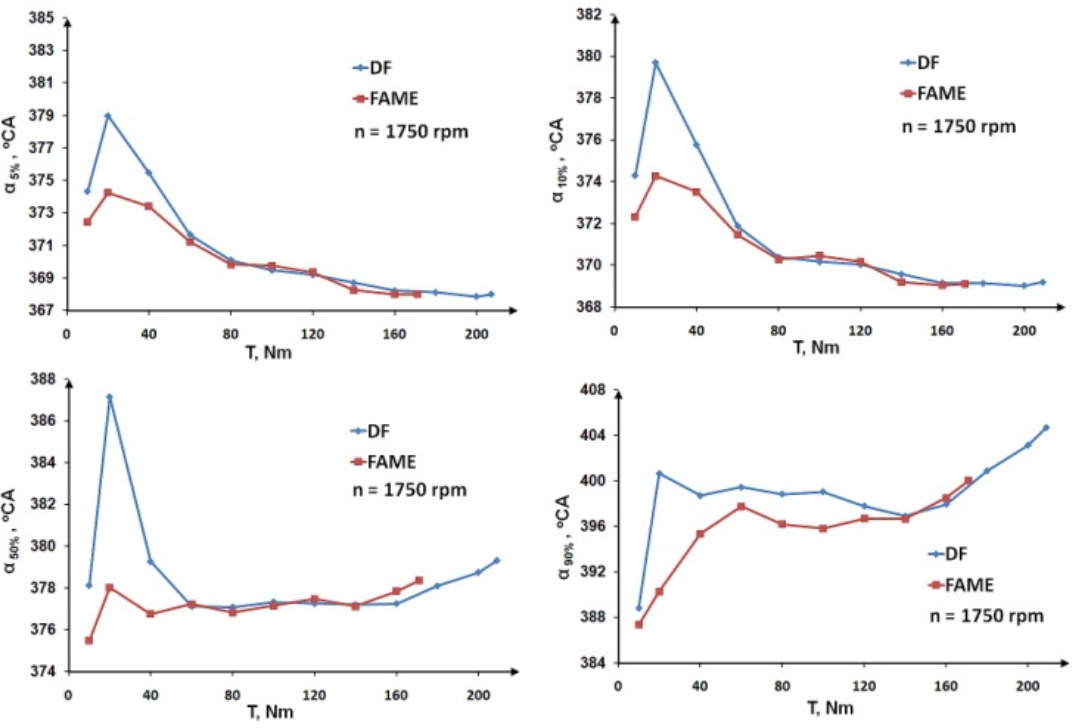
Figure 9: Angular values of crankshaft rotation of the engine at which 5, 10, 50 and 90% of the fuel dose was burned in the Fiat 1.3 MultiJet engine cylinder working according to the load characteristics for n = 1750 rpm, supplied with the following fuels: FAME,